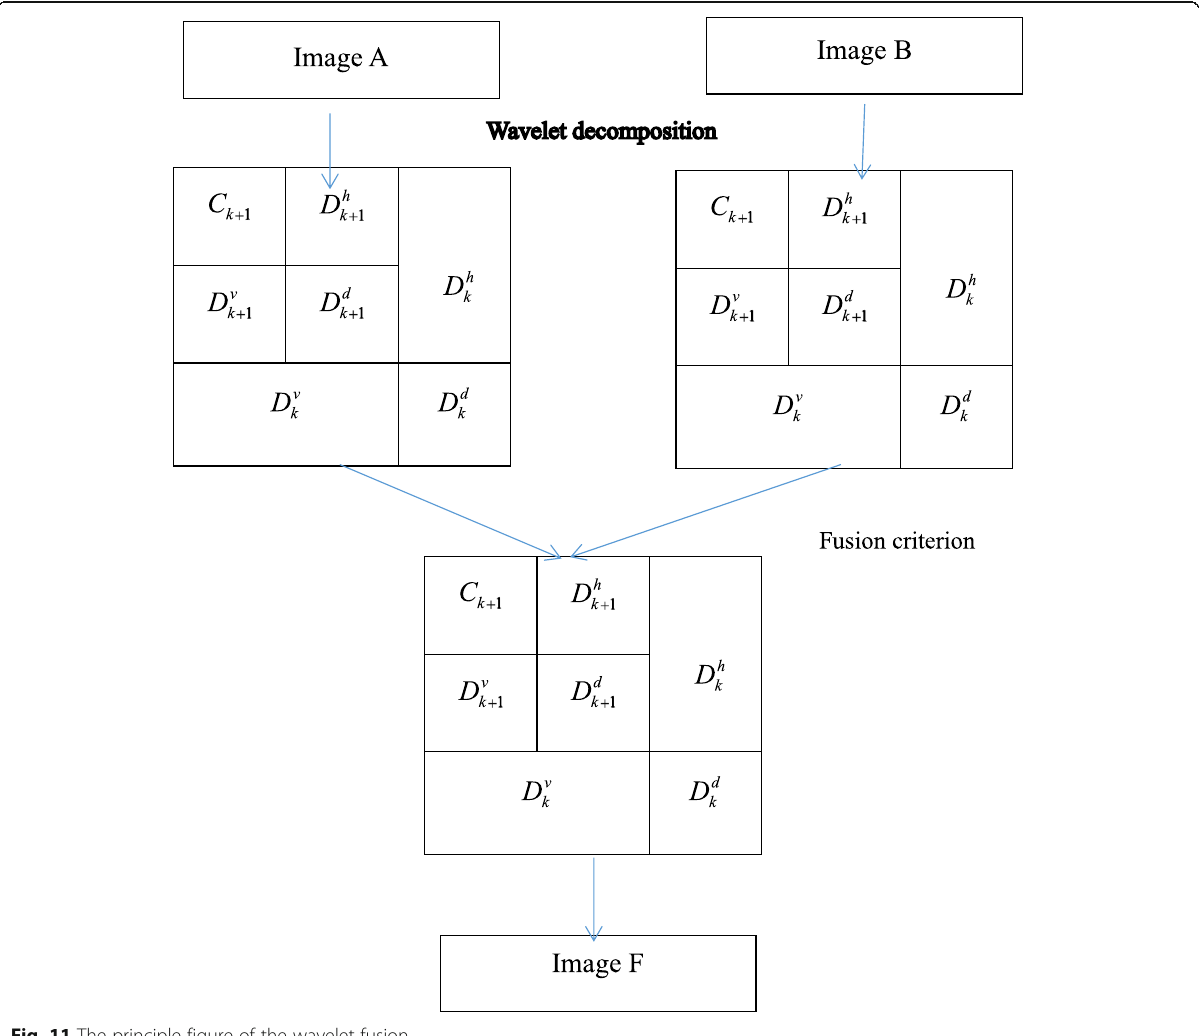
Fig. 11 The principle figure of the wavelet